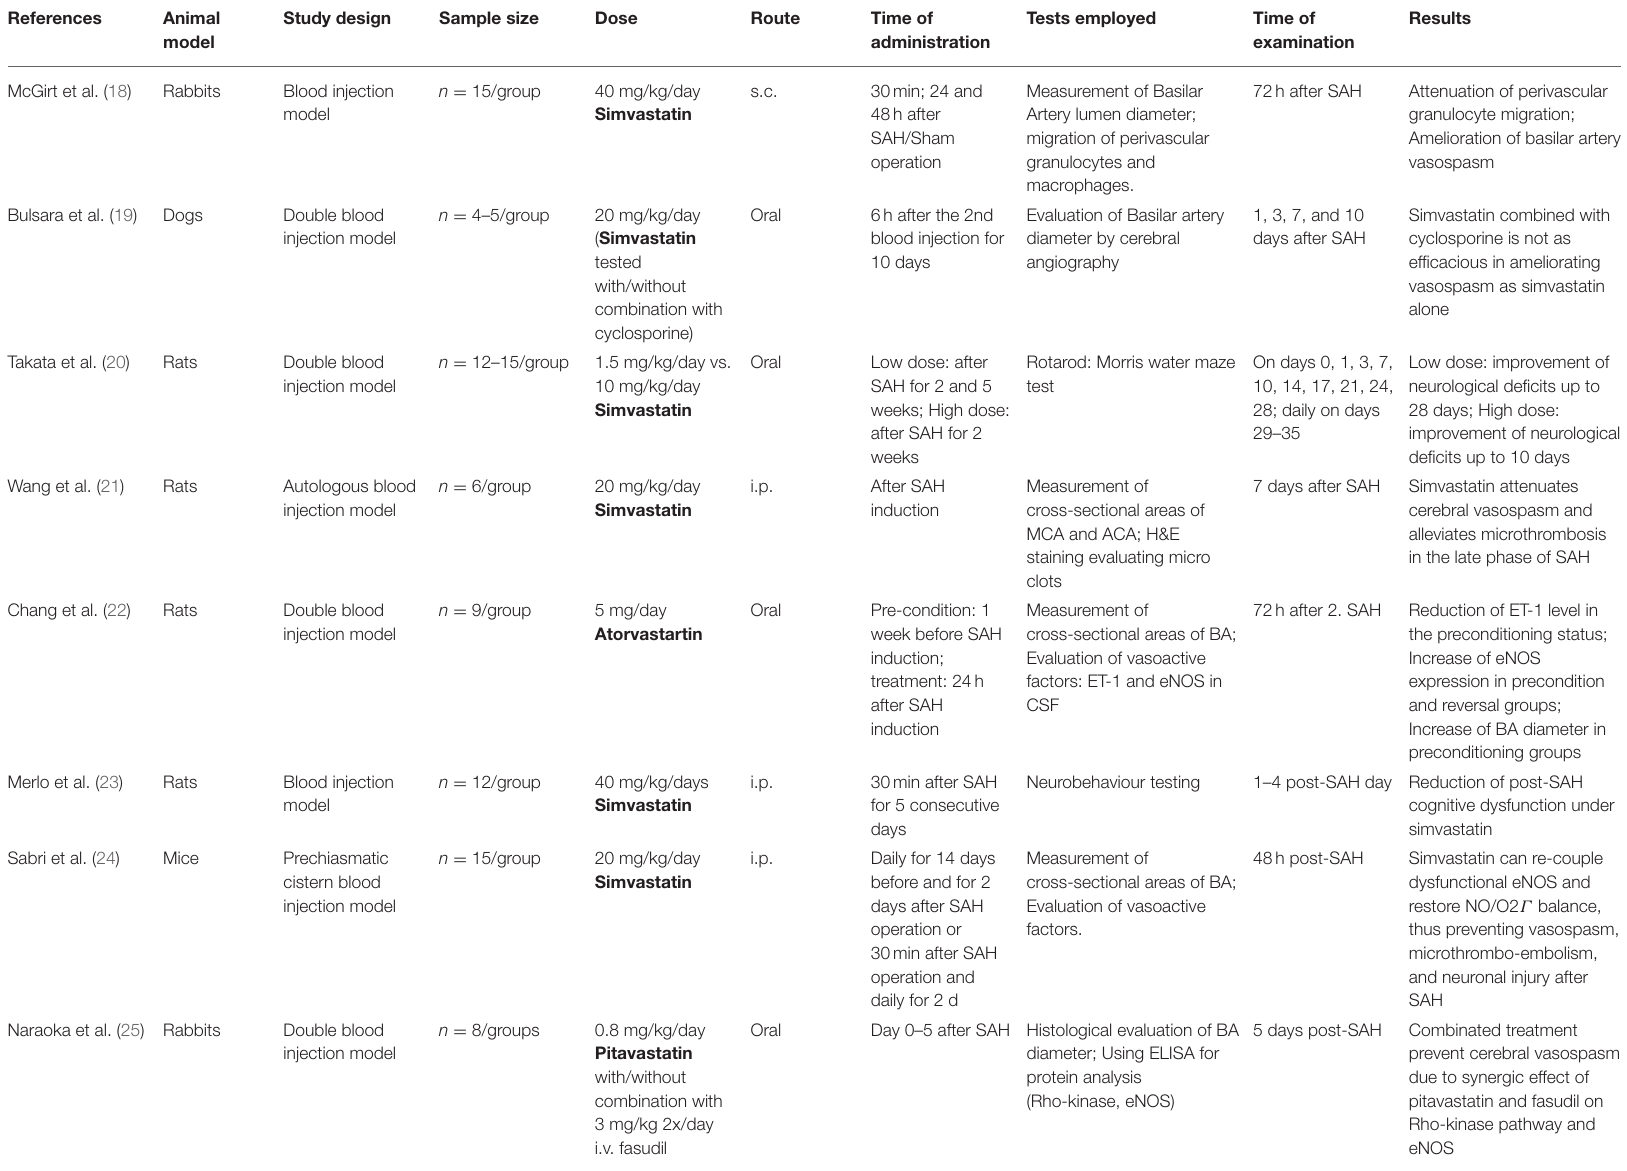
TABLE 1 | Experimental studies assessing neuroprotective effects of Statin on SAH using blood injection